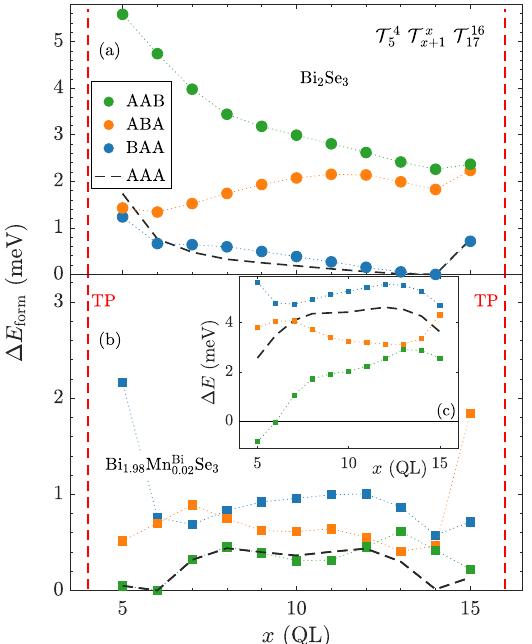
Figure 10. Dependences of the relative formation energies of three TPs on the position of the middle TP x . Different mutual orientations of the TPs are used. The orientation of TPs is labeled by letters A and B. ( a ) undoped structure. ( b ) magnetically doped structure. ( c ) change of the TP formation energy caused by presence of the magnetic defects—Bi 1.98 Mn 0.02 Se 3 with respect to the undoped case. The relative formation energy curve related to identical TPs ( AAA —dashed lines) depicted in panels ( a , b ) serves only as a shape reference.